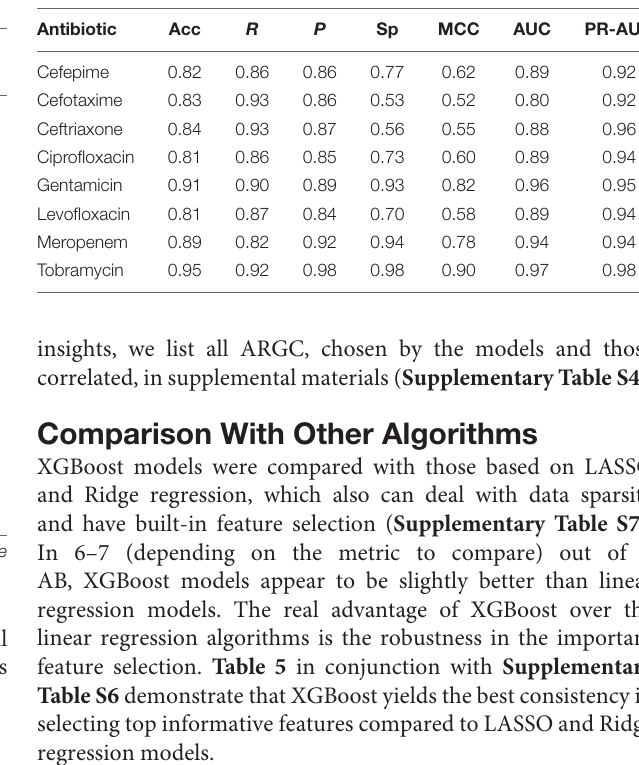
TABLE 3 | Performance of final ABR prediction